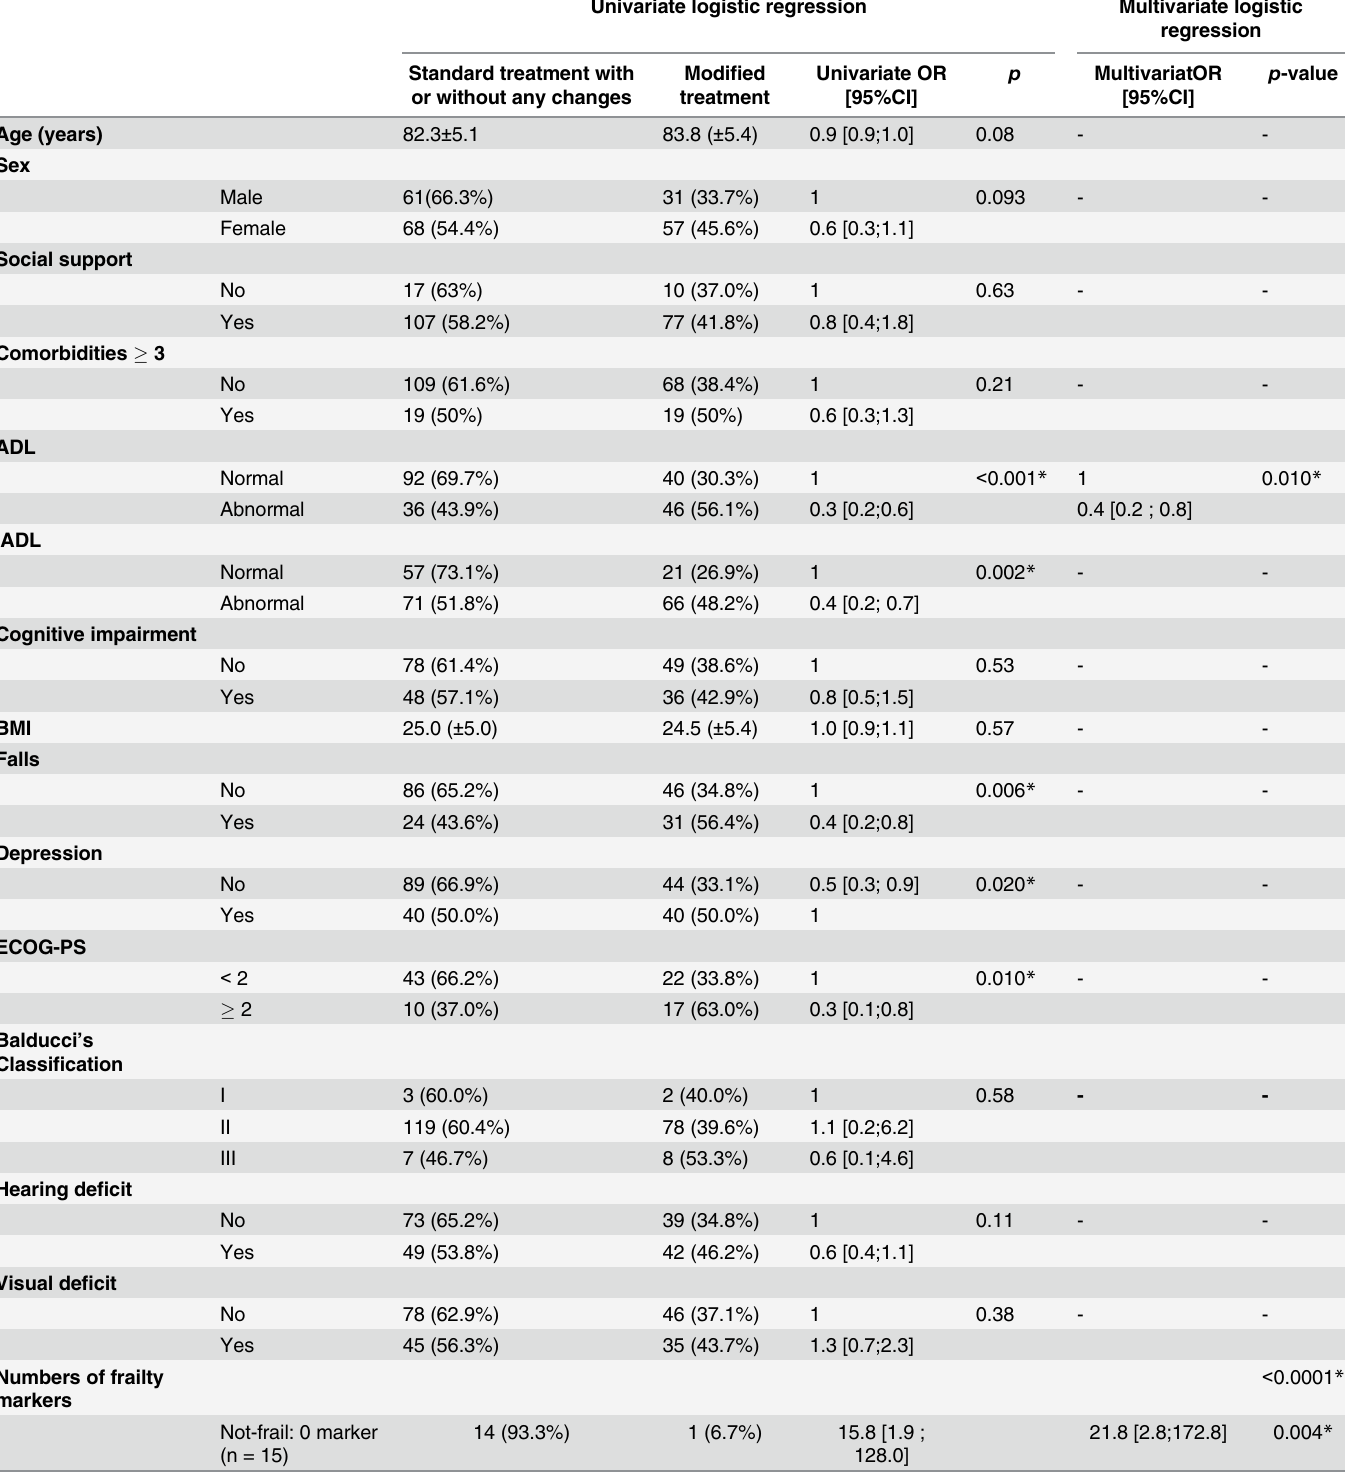
Univariate logistic